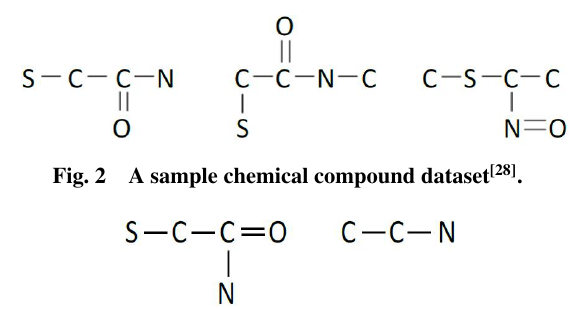
Fig. 1 Undirected (left) and directed (right) labeled graphs.